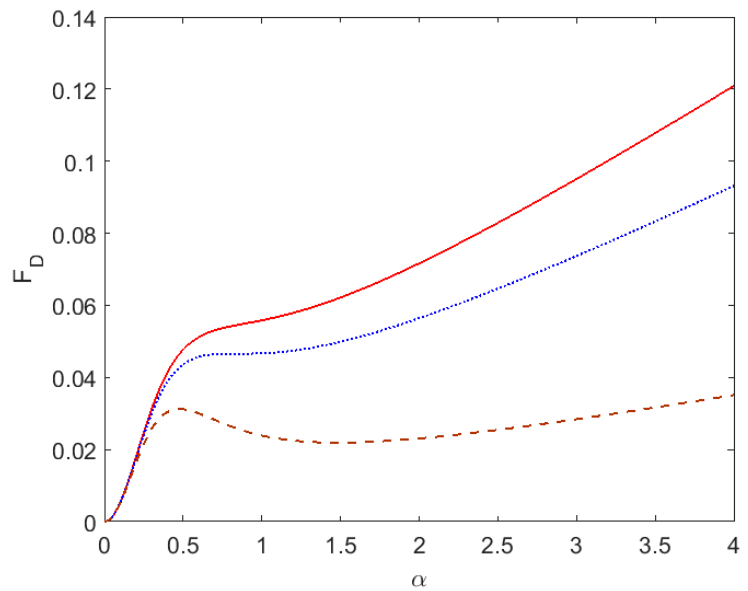
Figure 1. Dependence of Doppler function F D upon dimensionless pulse duration for different values of dimensionless detuning δ : solid line − δ = 2.3, dotted line − δ = 2.414, dashed line − δ = 2.8.